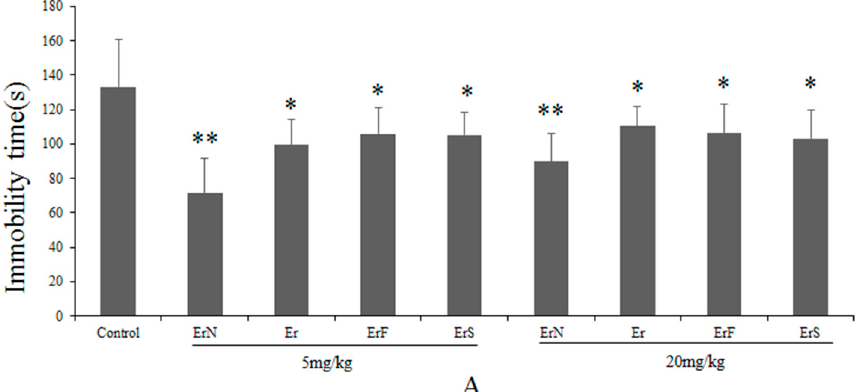
Figure 2E. The sub-effective dose of ErN and reboxetine interaction considerably reduced the immobility time in the FST compared to either of those treated alone as well as the control group.